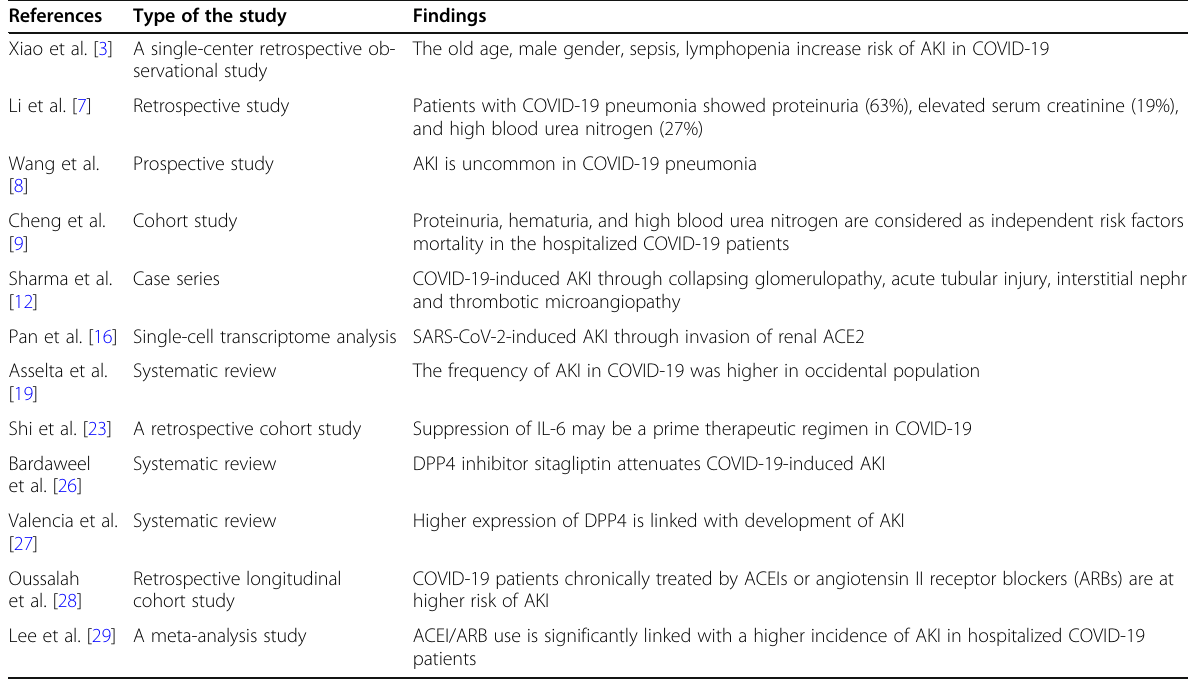
Table 1 The association between acute kidney injury (AKI) and COVID-19